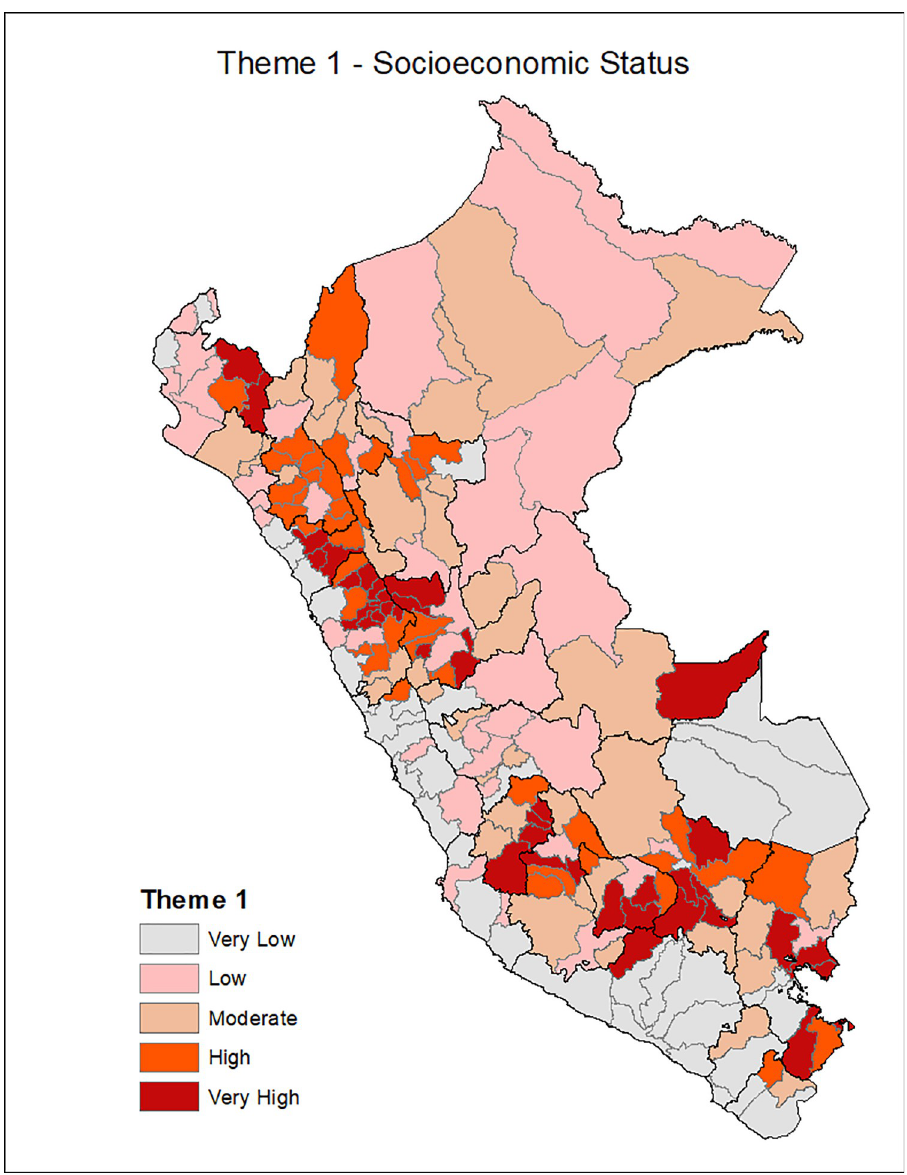
Fig 2. SVI topic 1: Scioeconomic